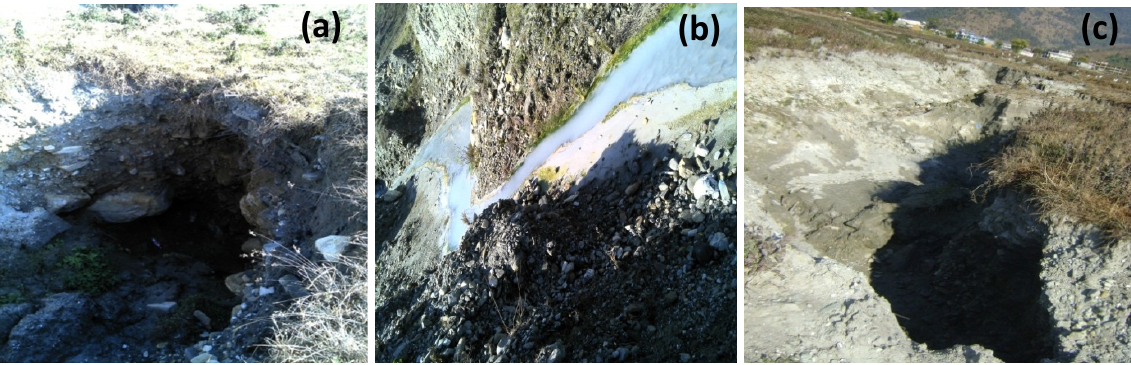
Figure 8. ( a ) Sinkhole in the Armala area; ( b ) Identified watercourse after the sinkhole; ( c ) Sinkhole in the Armala area,